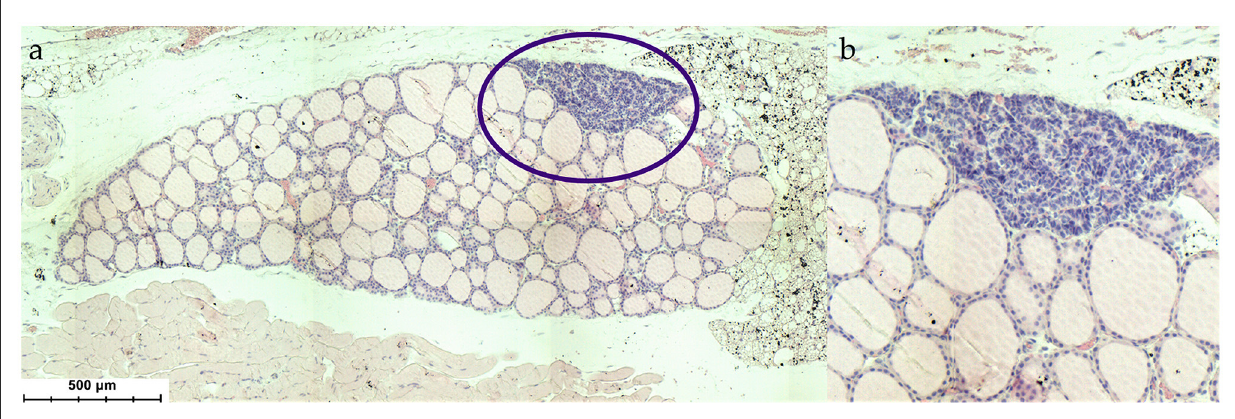
FIGURE2 (a) Histological situs of the parathyroid gland within the thyroid ( Mus musculus ), (b) magnification of the parathyroid gland. HE stain.